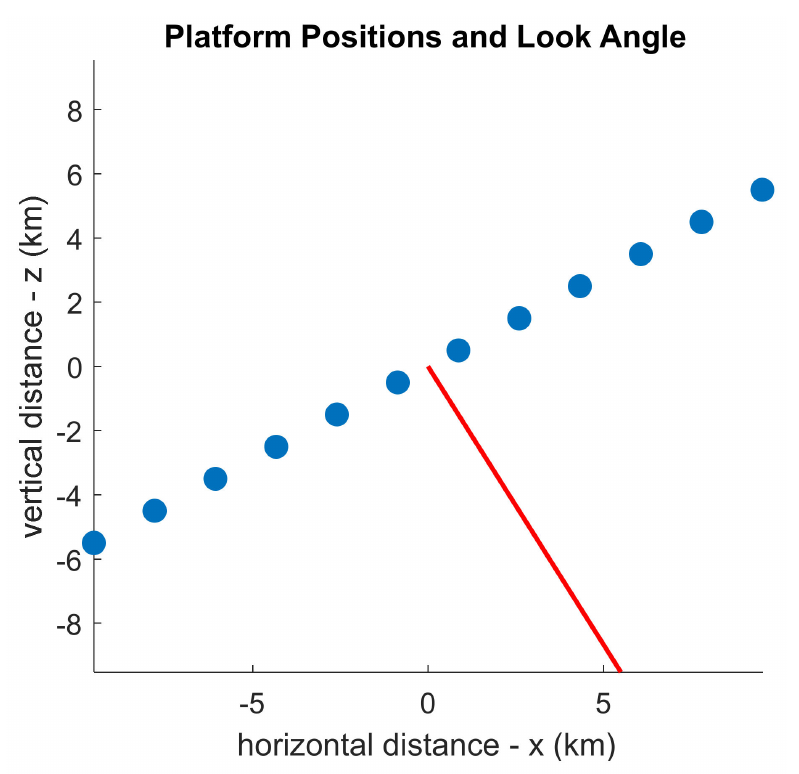
Figure 31. The observation geometry for Example 8. Blue dots represent the platform locations and the red line represents the look angle.